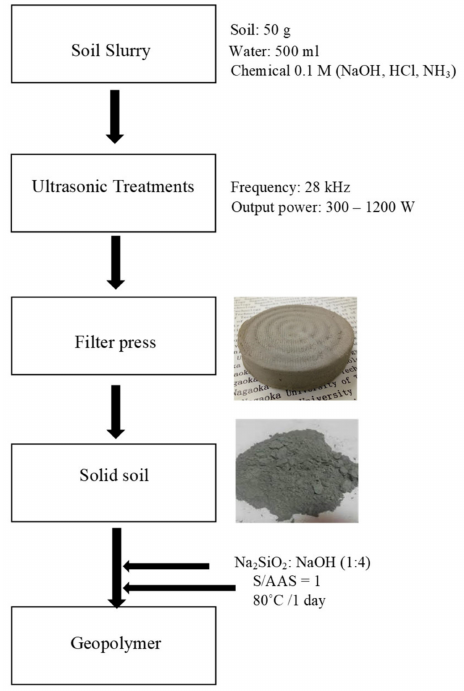
Figure 2. Protocol for US soil washing, and geopolymer